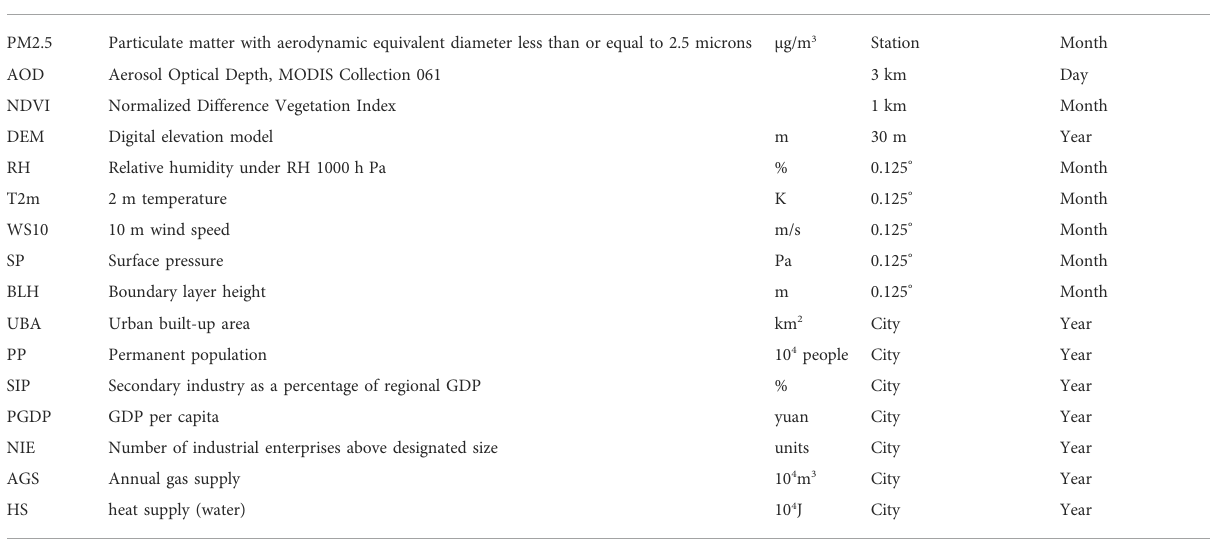
TABLE 1 Description of all data used in this